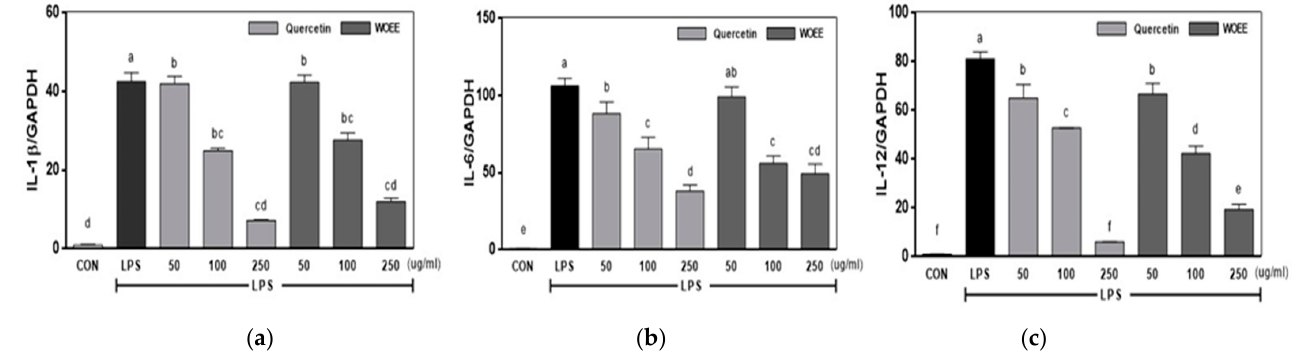
Figure 5. Anti-inflammatory effects of quercetin and WOEE on LPS-stimulated RAW 264.7 macrophages. ( a ) IL-1β, ( b ) IL-6, and ( c ) IL-12 gene expressions of the cells treated with LPS, quercetin, and WOEE. The data were analyzed by one-way ANOVA using SPSS software and each bar presents the mean ± SE. (n = 3). a–f Mean values with different letters are significantly different ( p < 0.05) among groups, determined by Duncan’s multiple range test.